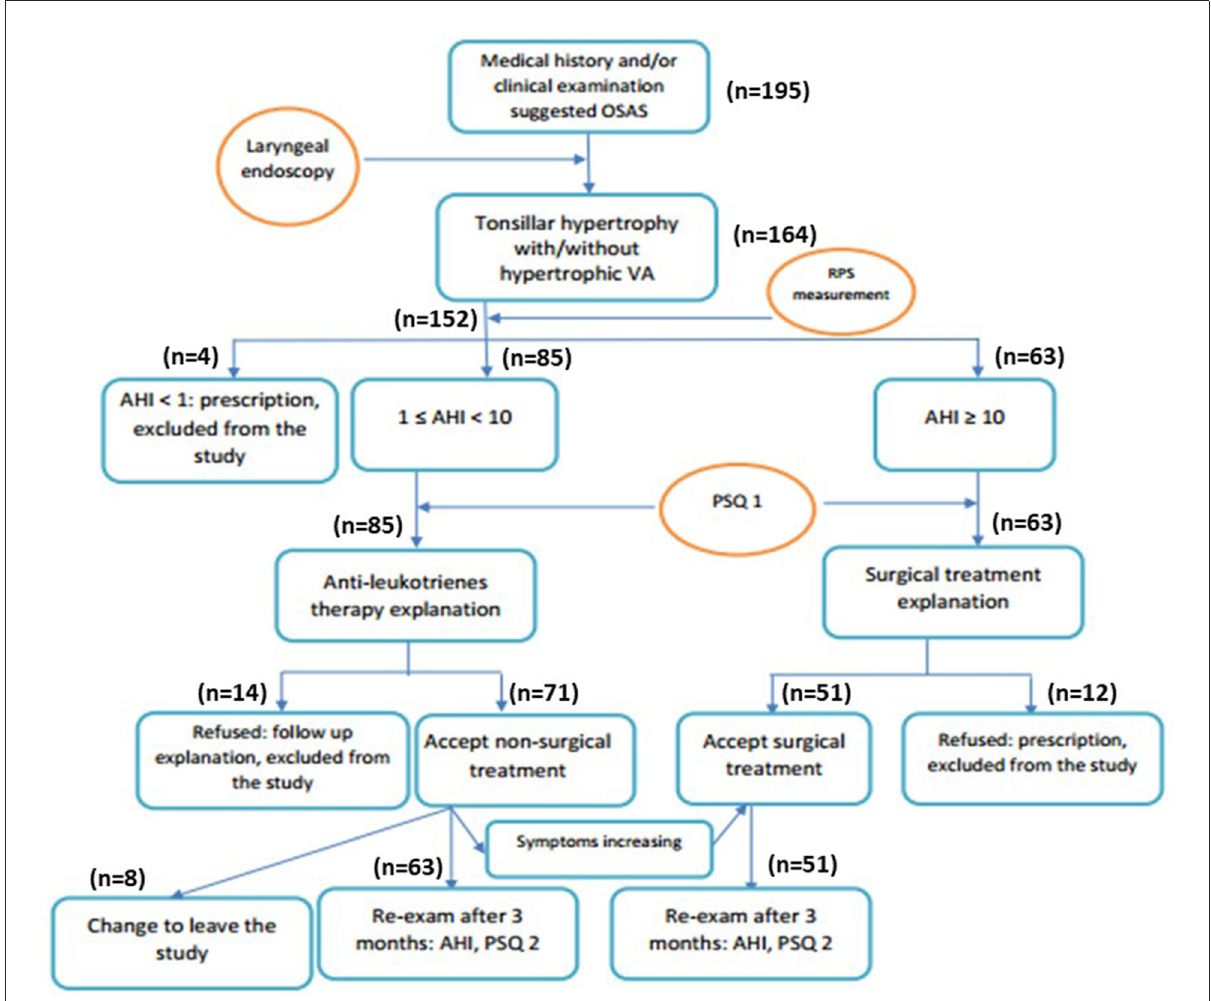
FIGURE1 Flow-chart of study process. AHI, apnea-hypopnea index; PSQ, pediatric sleep quality; RPS, respiratory